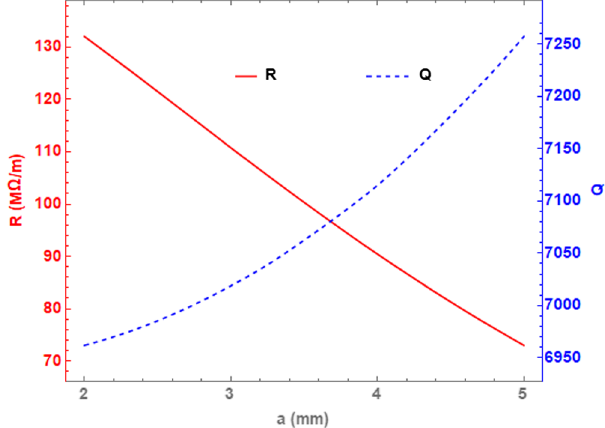
FIG. 5. The shunt impedance per unit length R 0 and Q factor of the single cell tuned to 11.9942 GHz in the 2 π = 3 mode as a function of cell iris radius a .